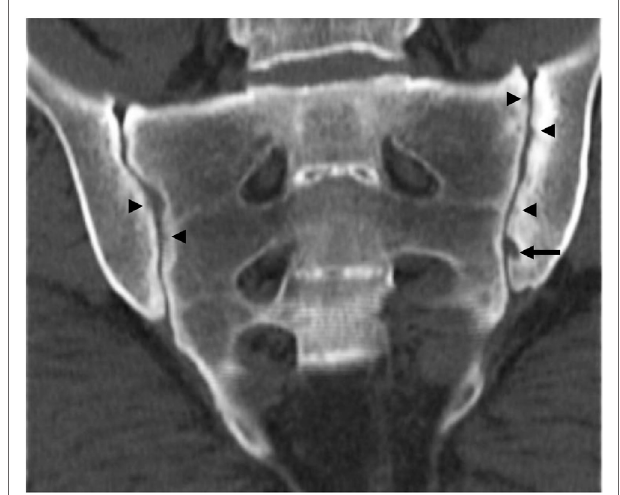
FiGURe 3 | Computed tomography of the sacroiliac joints (same patient as depicted in Figures 1 and 2 ) demonstrating subchondral sclerosis predominantly of the left ilium, multiple bilateral small erosions (arrowheads), and a large erosion of the left ilium